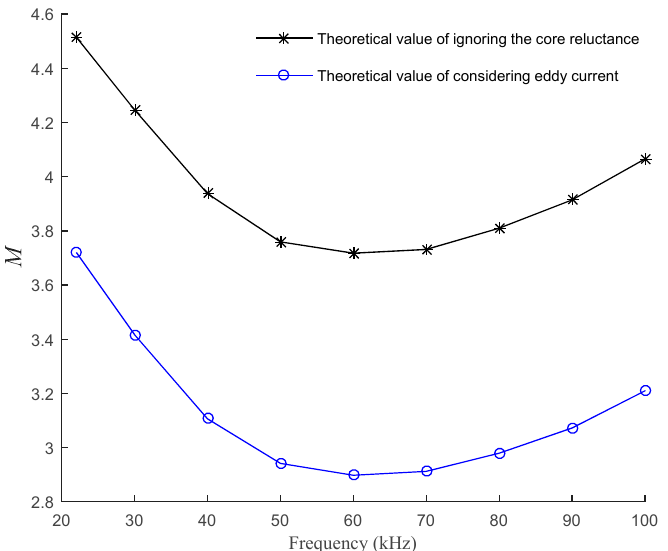
Figure 16. Variation of M with frequency.